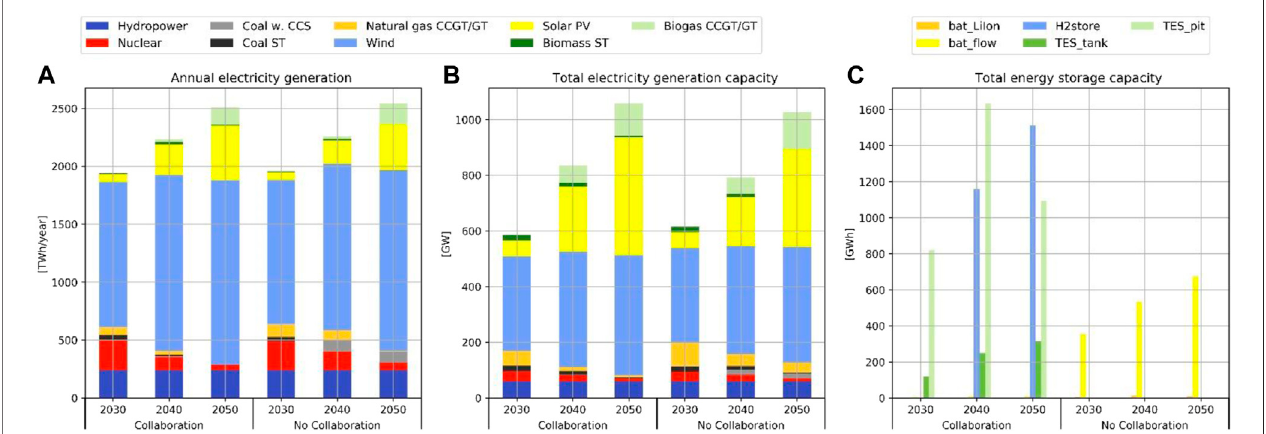
FIGURE 2 | Modelling results, as obtained from the two scenarios investigated in this work. (A) The annual electricity generation; (B) the total installed electricity generation capacity; and (C) the total energy storage capacity , for the two scenarios for Years 2030, 2040 and 2050. CCS, Carbon capture and storage, here with biomass blending for zero total emissions; CCGT, combined-cycle gas turbine; ST, steam turbine; H2store, hydrogen storage; TES, thermal energy storage; bat_Lion, Li-ion stationary batteries; bat_ fl ow, fl ow stationary batteries. The batteries in electric cars are not included in this graph.